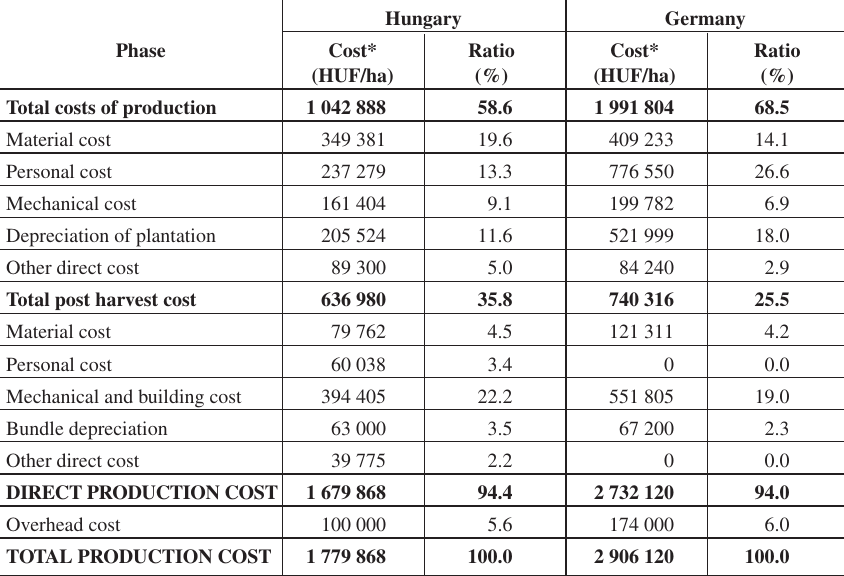
Table 2 . Cost Structure of Cost Types in the Productive Period*